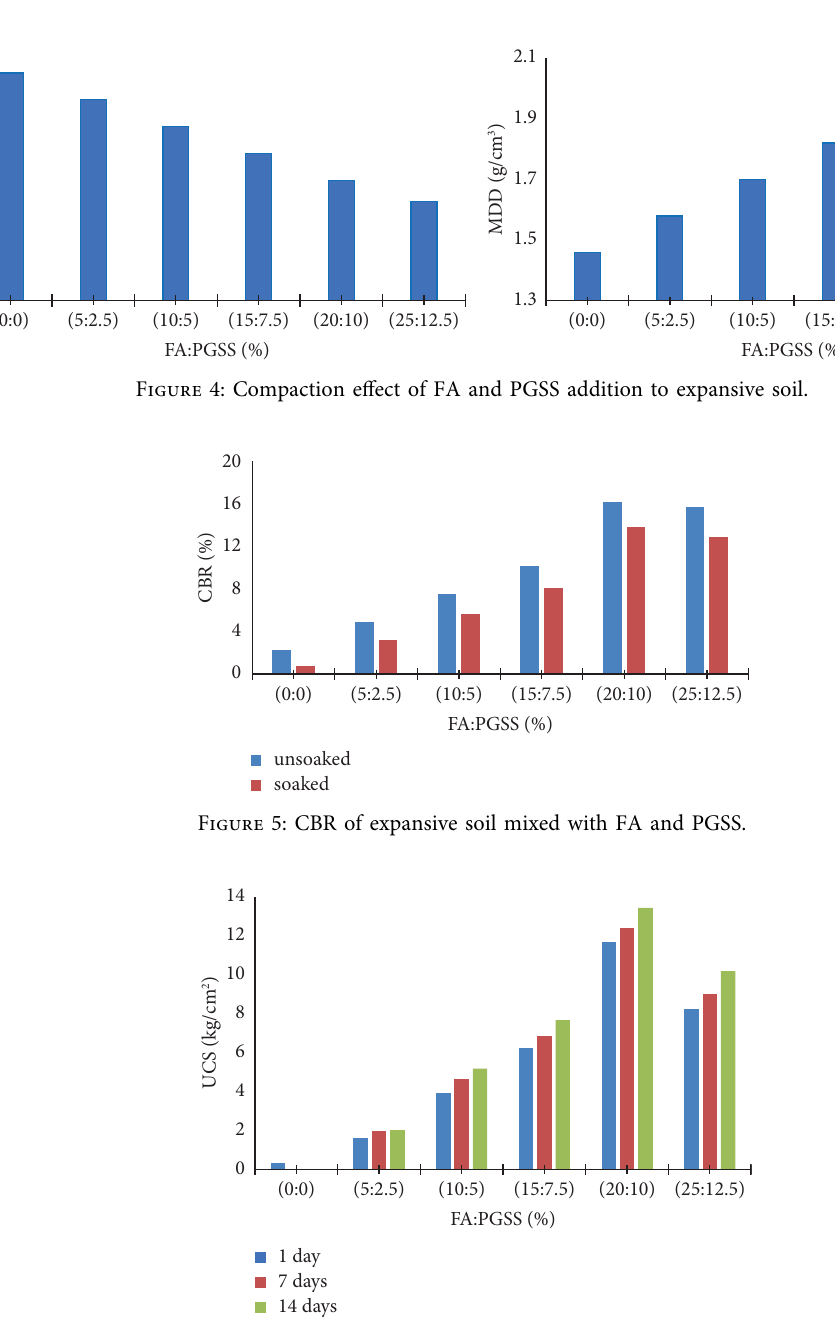
Figure 6: UCS for expansive soil with and without FA and PGSS